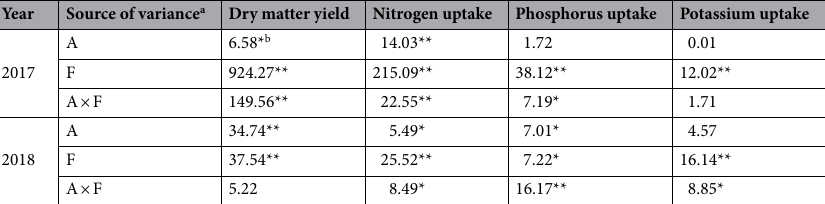
Table 5. Effects of dripline spacing and fertilization rate on dry matter yield and nutrient uptake of two-way analysis of variance ( F value). a A and F represent dripline spacing and fertilization rate, respectively, as shown in Fig. 2 and Table 2. b * and ** show significant difference at the 0.05 and 0.01 probability levels, respectively.